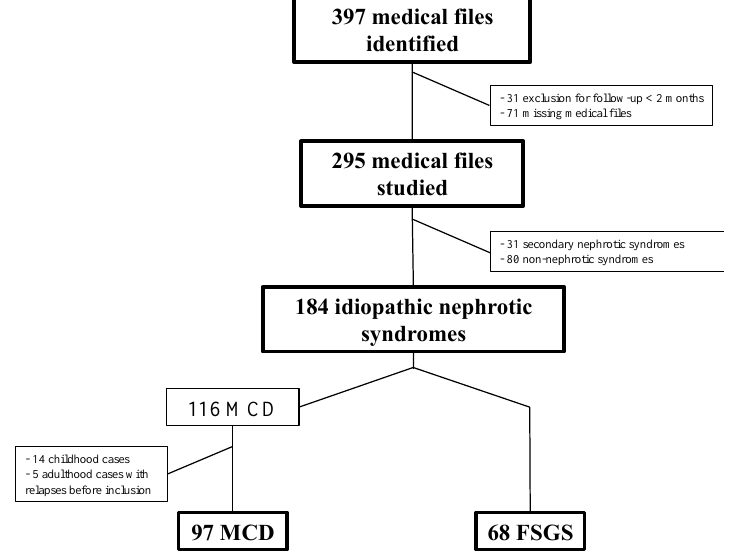
Figure 1. Flow chart. MCD: minimal change disease; FSGS: focal segmental glomerulosclerosis.